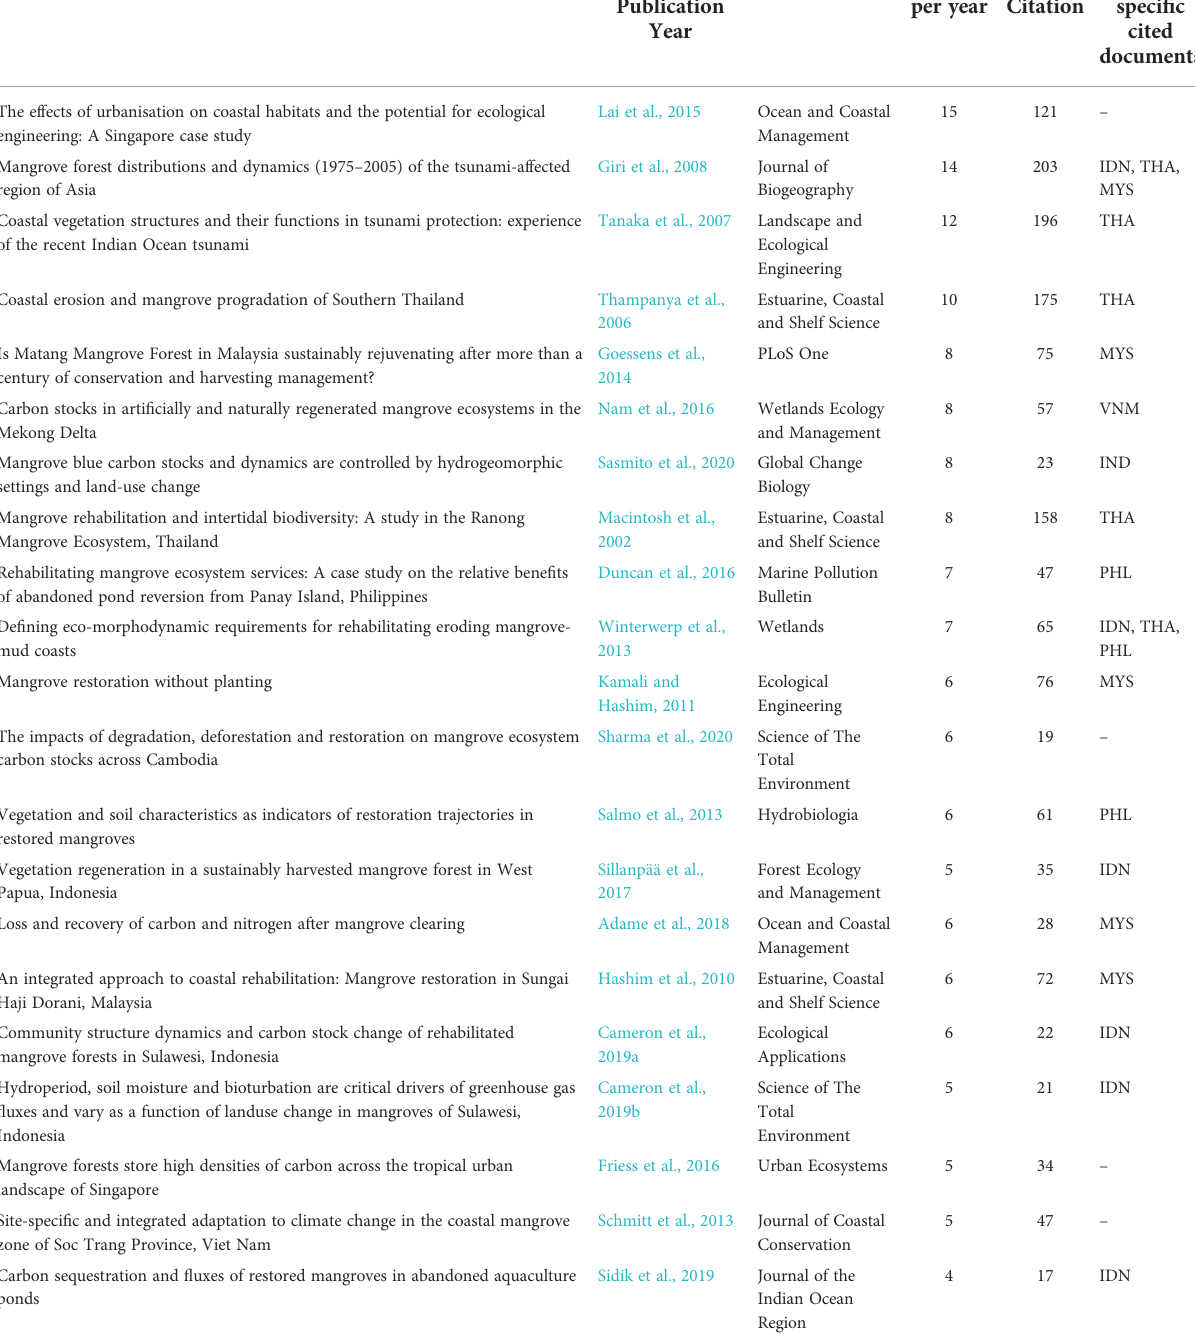
TABLE 2 Most frequently cited articles on mangrove studies with ecological attributes in SE Asia and the top cited document per